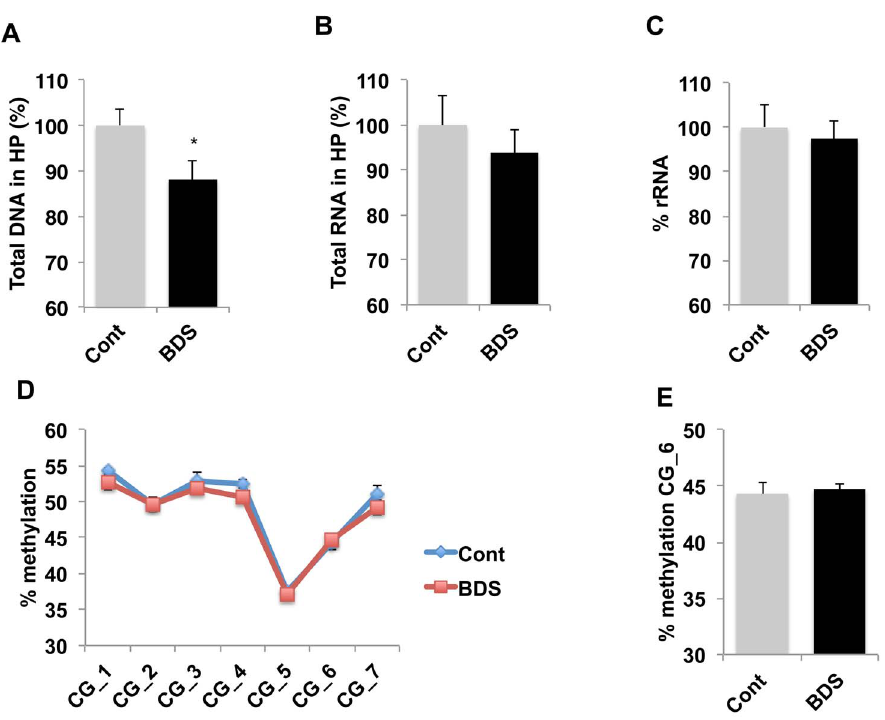
Fig. 5. Exposure to BDS reduces DNA content in 28-day old pups without affecting levels of rRNA or DNA methylation at CG_6. Exposure to BDS decreases total amount of DNA (A), but not RNA (B), harvested from the hippocampus of 28-day old offspring. C. Relative levels of rRNA are similar in BDS compared to control 28-d old mice. The effects of BDS on DNA methylation at CG_6 do not persist in 28-day old mice (D and E). Unpaired Student t tests (A, B, C, E), Repeated measures ANOVA (D). Error bars represent mean ¡ SEM, *p ,